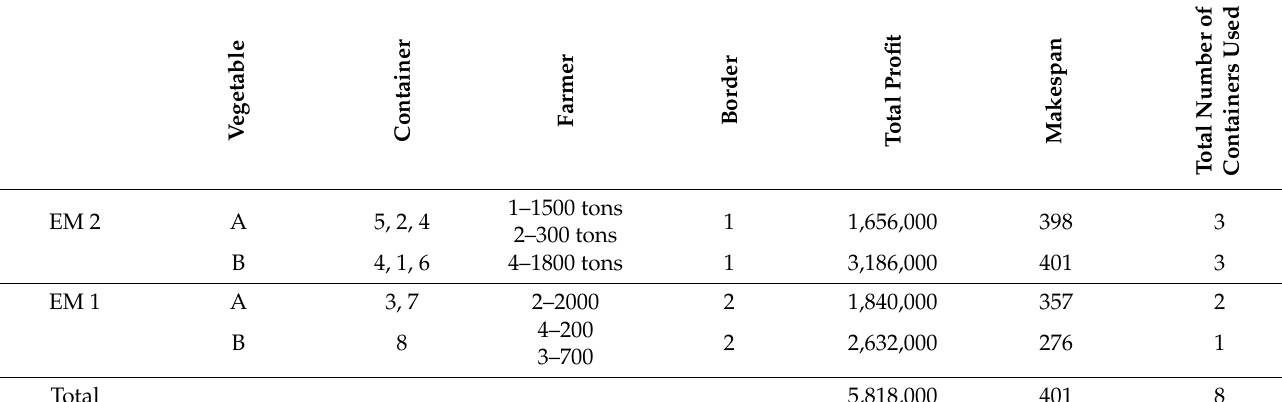
Table 7. Results of the assignment process of WP number